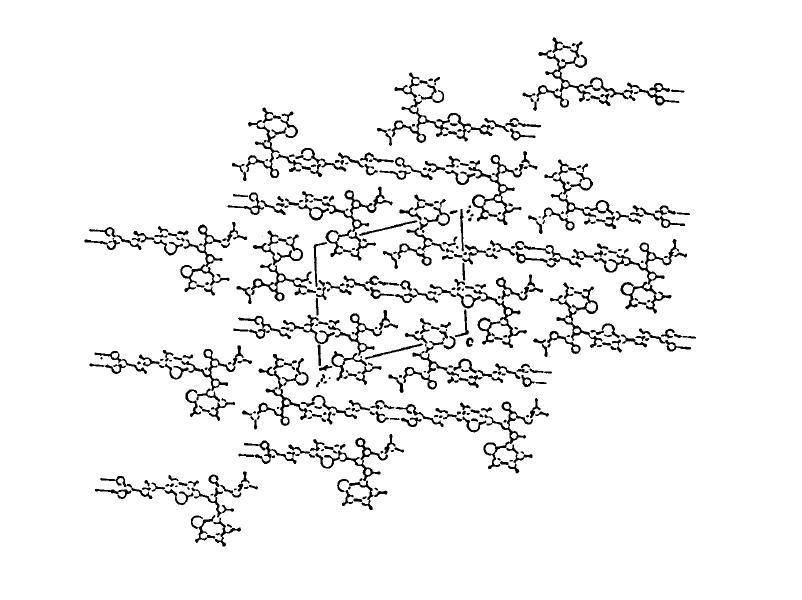
Figure 2. X-Ray structure of 3-{5-[1-methoxycarbonyl-2-(2-thienyl)-ethenyl]-2- thienyl}acrylic acid ( 5 ) bonded into dimers via